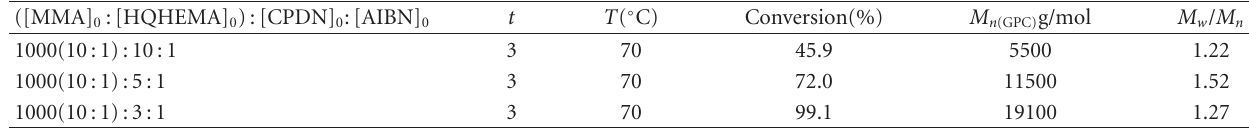
Table 1: RAFT copolymerization of HQHEMA and MMA with di ff erent CPDN concentrations.